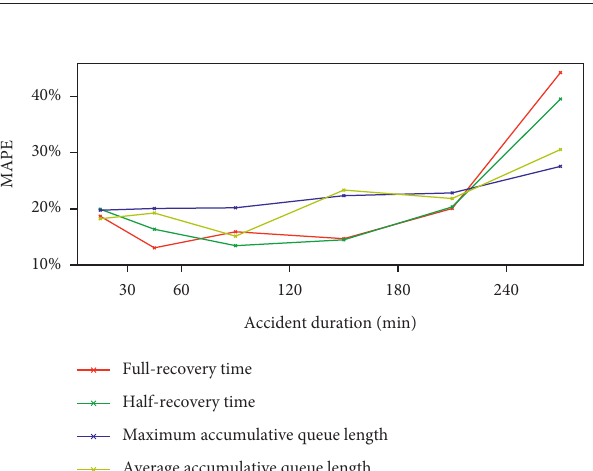
Figure 16: MAPE in spatial-temporal impact in accident duration intervals of 6-lane cases. The cross-point represents the average value in that